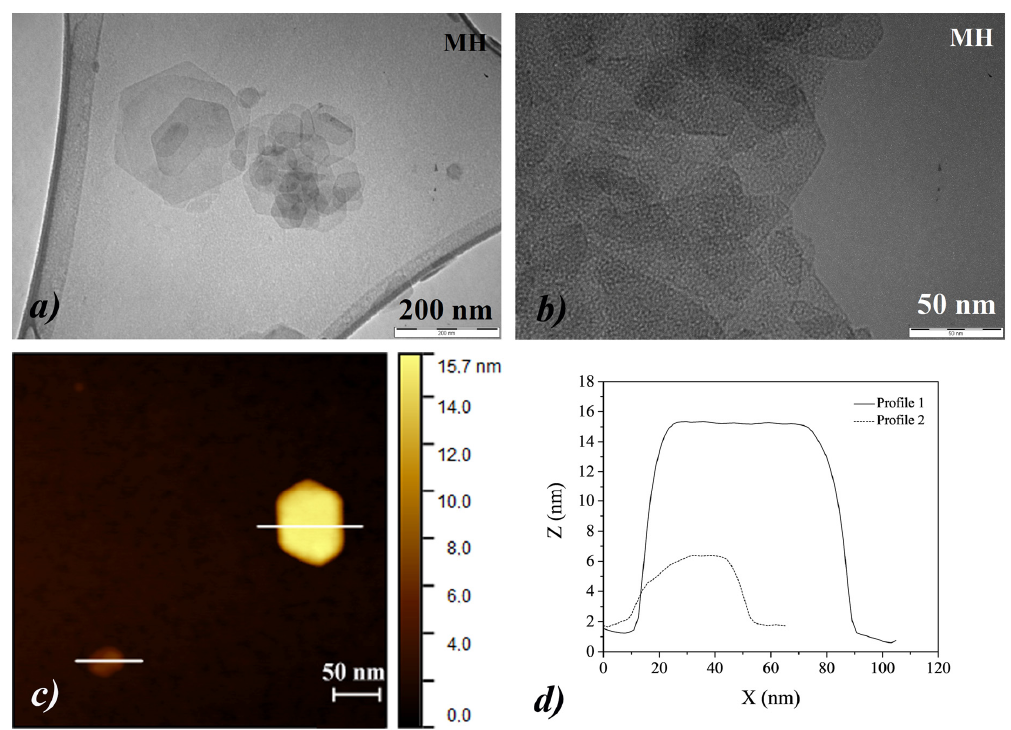
Figure 6. ( a , b ) TEM images of MH nanoparticles, acquired at different magnifications; ( c , d ) AFM image of MH nanoparticles together with the corresponding profile analysis along the Z -axis.